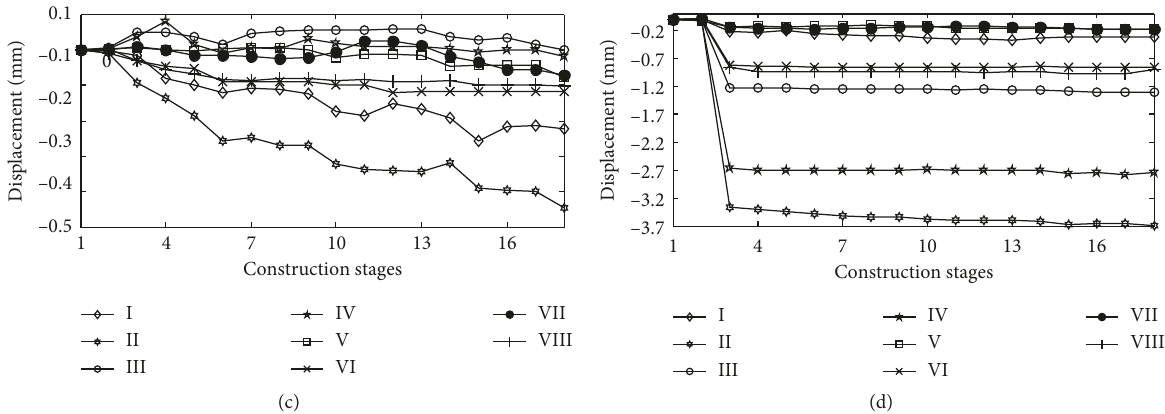
Figure 13: Comparison of vertical displacement of existing buildings: (a) left building farthest from excavation; (b) left building nearest from excavation; (c) right building farthest from excavation; (d) right building nearest from excavation.